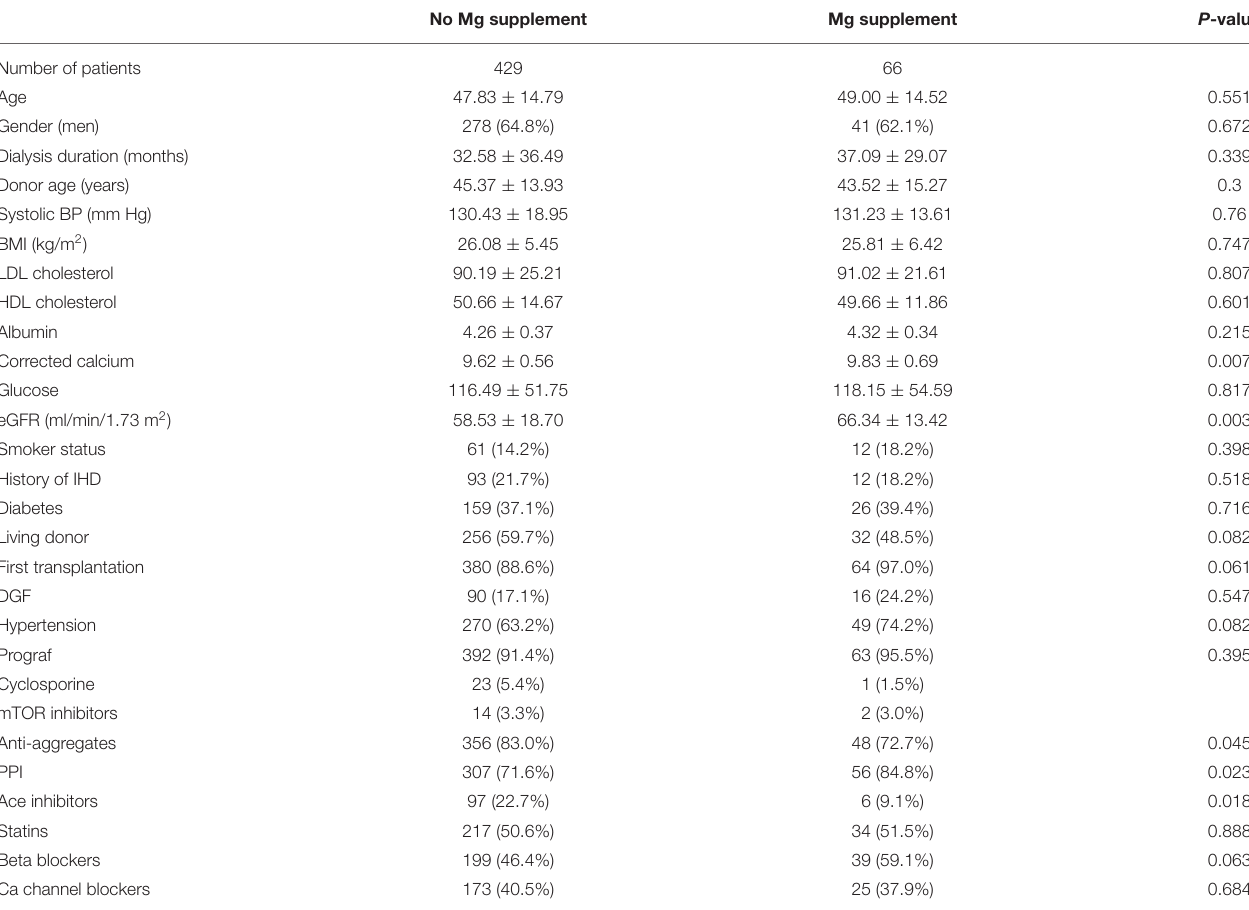
TABLE 6 | Baseline characteristics of patients treated with magnesium supplementation vs. untreated